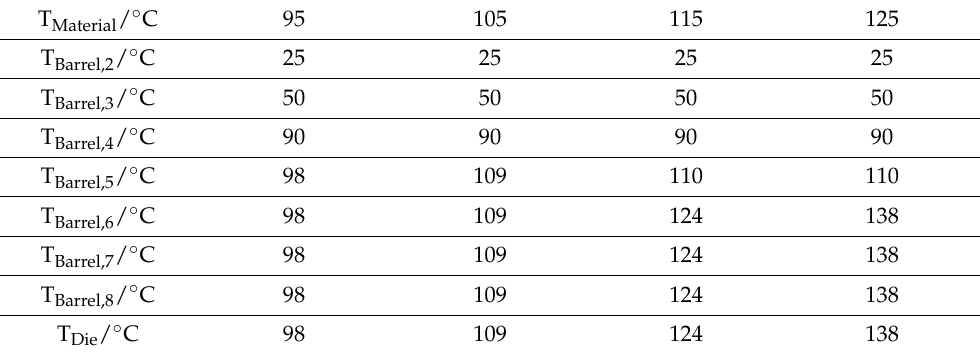
Table 1. Temperature profiles of the extrusion trials at the four different material temperatures. Dead-stop trials were performed with the same specific temperature profiles at 95 ◦ C and 125 ◦ C. T Material / ◦